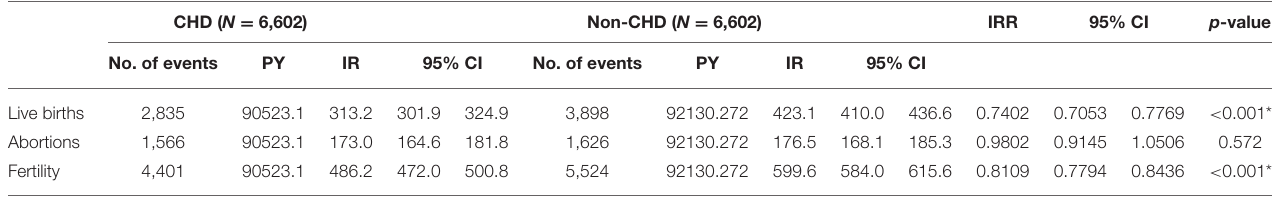
TABLE 2 | Live births, abortions, and fertility of CHD and